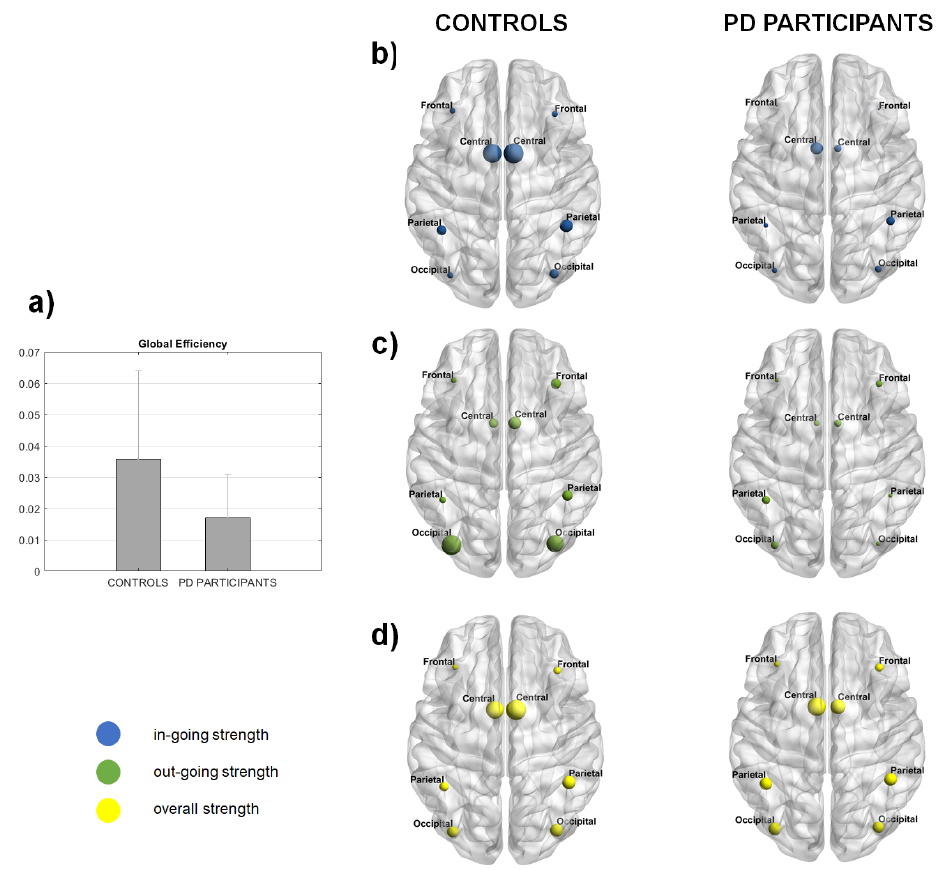
Figure 3. ( a ) Global efficiency and ( b ) in-going, ( c ) out-going ( d ) and overall strength for each node, in controls and PD participants. Indices were computed after applying the threshold at GC matrices for each subject. ( a – d ) represent the grand average. The error bar in ( a ) represents the standard deviation. The size of the node is proportional to the value of the